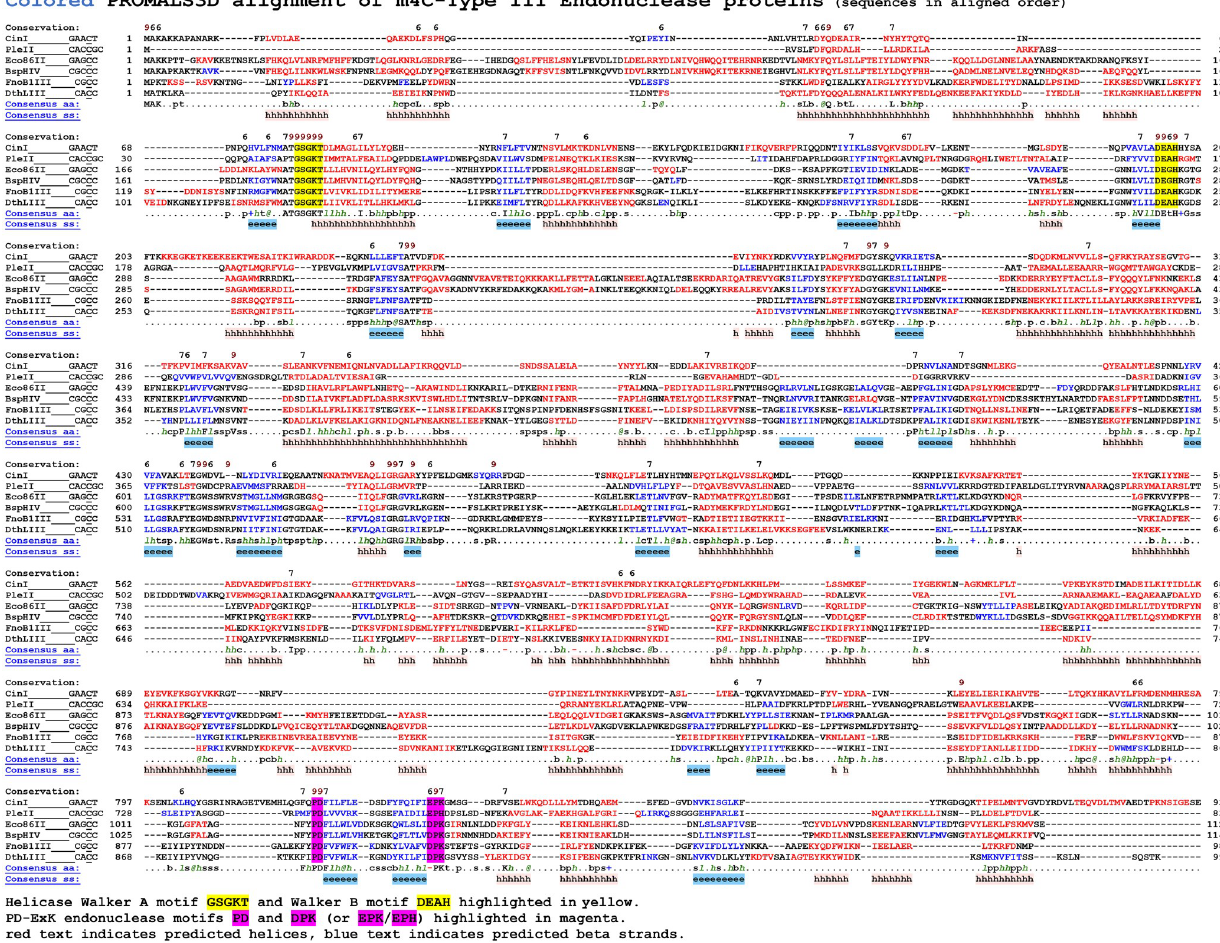
(M.Eco86II) methylates the C at the fourth position of 5’-GAGCC-3’ . Perhaps unsurpris- ingly, recombinant expression of this E . coli gene in our laboratory E . coli strain gave full meth- ylation that was specific for the native site, even when expressed from the high copy vector, Table 2. We expressed the methyltransferase of both of the putative Type III systems found in A . species H and performed methylome analysis. M.BspHIV, locus tag HUK62_04085, was found to efficiently methylate the C at the fourth position of 5’-CGCCC-3’ when expressed in E . coli . The other putative Type III system from this strain was found to modify adenine to m6A in the recognition motif AGCACC and was designated BspHIII (MTase gene locus tag is HUK62_00355) Table 2. The D . thermolithotrophum and F . nodosum Rt17-B1 systems (M. DthLIII and M.FnoB1III) were confirmed to methylate the Cs at the third position of 5’- CACC-3’ and 5’-CGCC-3’ , respectively, the latter motif having been previously reported by Blow et al ., [25]. Recombinant expression of the mod gene alone for M.BspHIV, M.CinI, M.Eco86II and M. PleII was sufficient to generate cytosine methylation in a laboratory E . coli strain lacking any